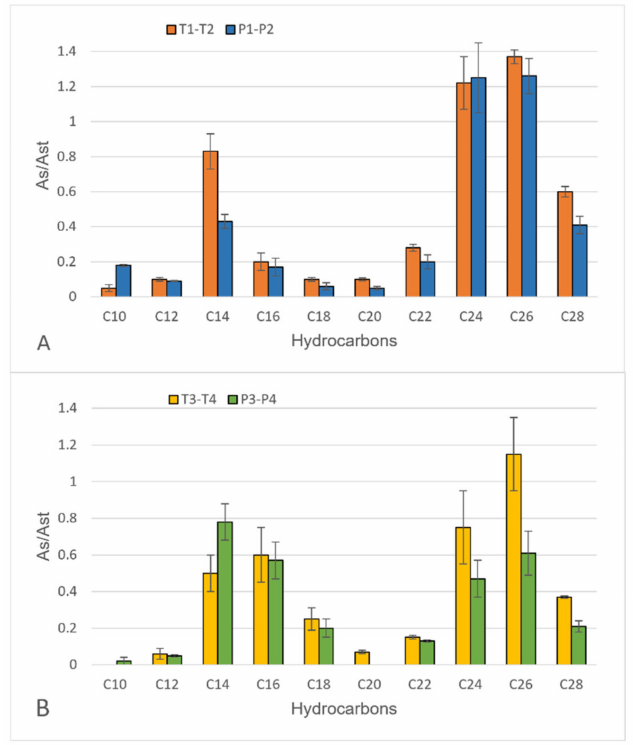
Figure 1. Results obtained from the semi-quantitative analysis of hydrocarbons (chain length: 10–28 C atoms) in treated water (T1 and T2 in orange) and shark tank water (P1 and P2 in blue) in sampling I ( A ). Results obtained from the semi-quantitative analysis of hydrocarbons (chain length: 10–28 C atoms) in treated water (T3 and T4 in yellow) and shark tank water (P3 and P4 in green) in sampling II ( B ). As/Ast represents the ratio between the hydrocarbon peak areas in the sample and in the reference standard.